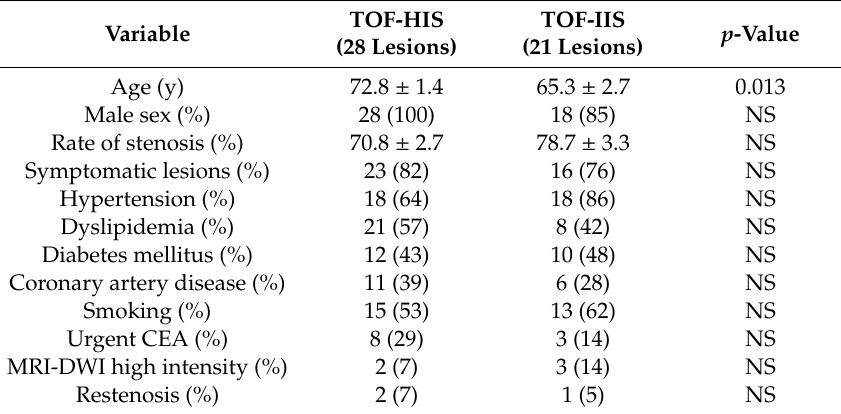
Table 1. Patient